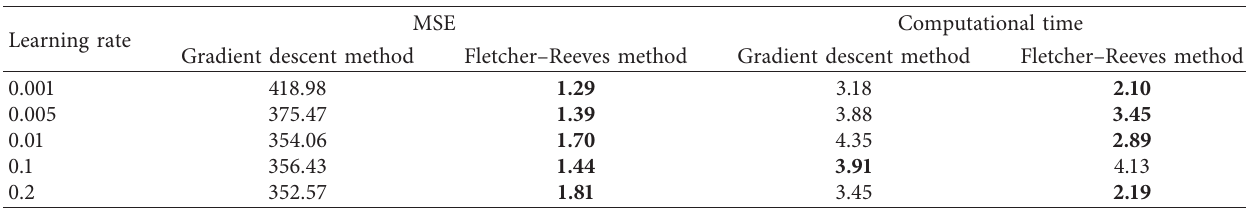
Table 6: Evaluation of the performance of the prediction method for the number of COVID-19 sufferers by using training data for several learning rates with 50 hidden